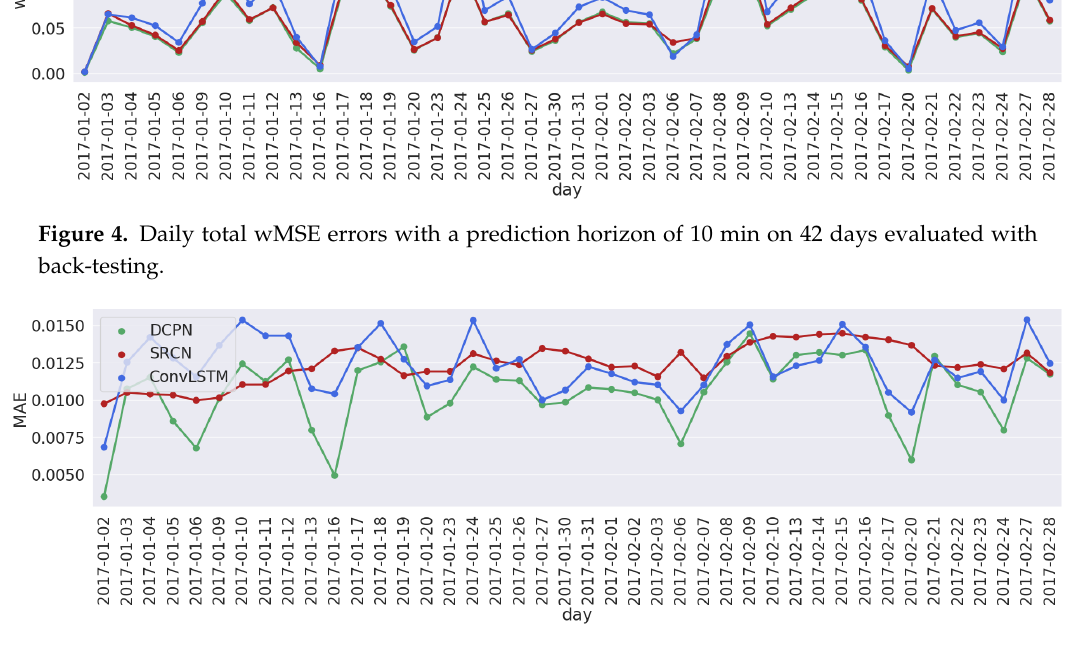
Figure 5. Daily total MAE errors with a prediction horizon of 10 min on 42 days evaluated with